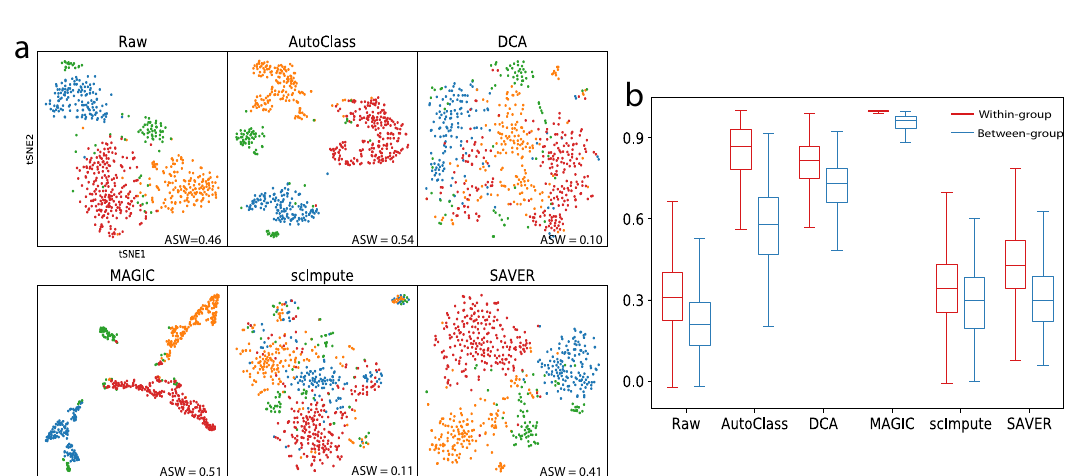
Fig. 4 Imputation results for the Usoskin dataset. a t-SNE plots for raw and imputed data. b Within-group and between-group cell-to-cell correlation for raw and imputed data. In b , the box represents the interquartile range, the horizontal line in the box is the median, and the whiskers represent 1.5 times the interquartile range, with sample size n = 50,000 randomly sampled cell